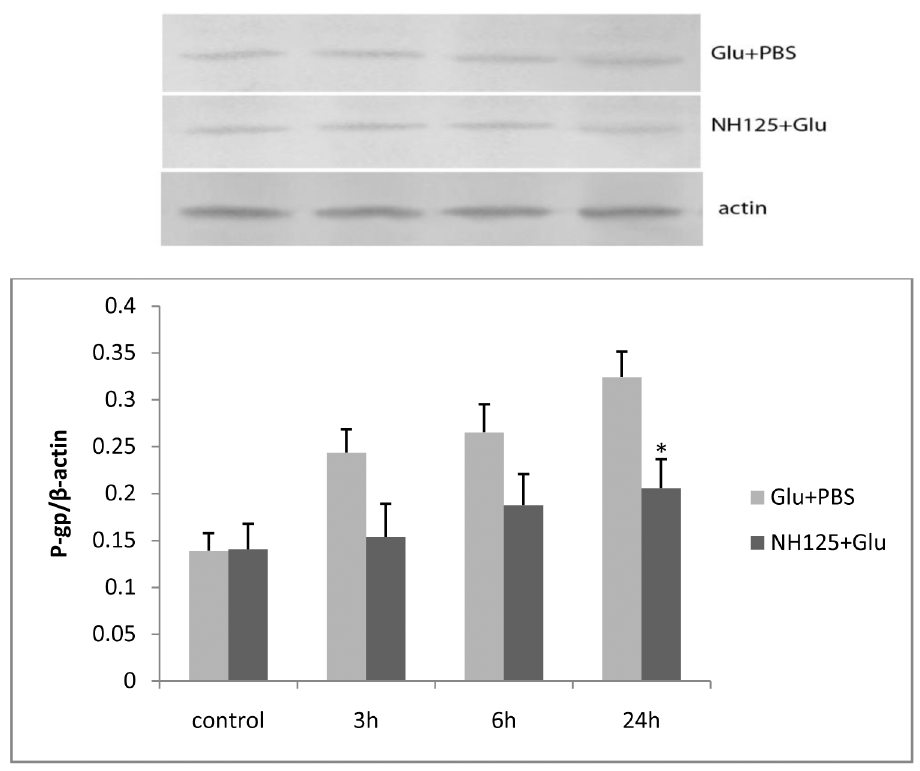
Fig 9. After adding 1 μ M NH125, expression of P-gp was lower in the NH125 + Glu group than that of the Glu + PBS group at 3, 6, and 24 h. The asterisk represents P < 0.05.